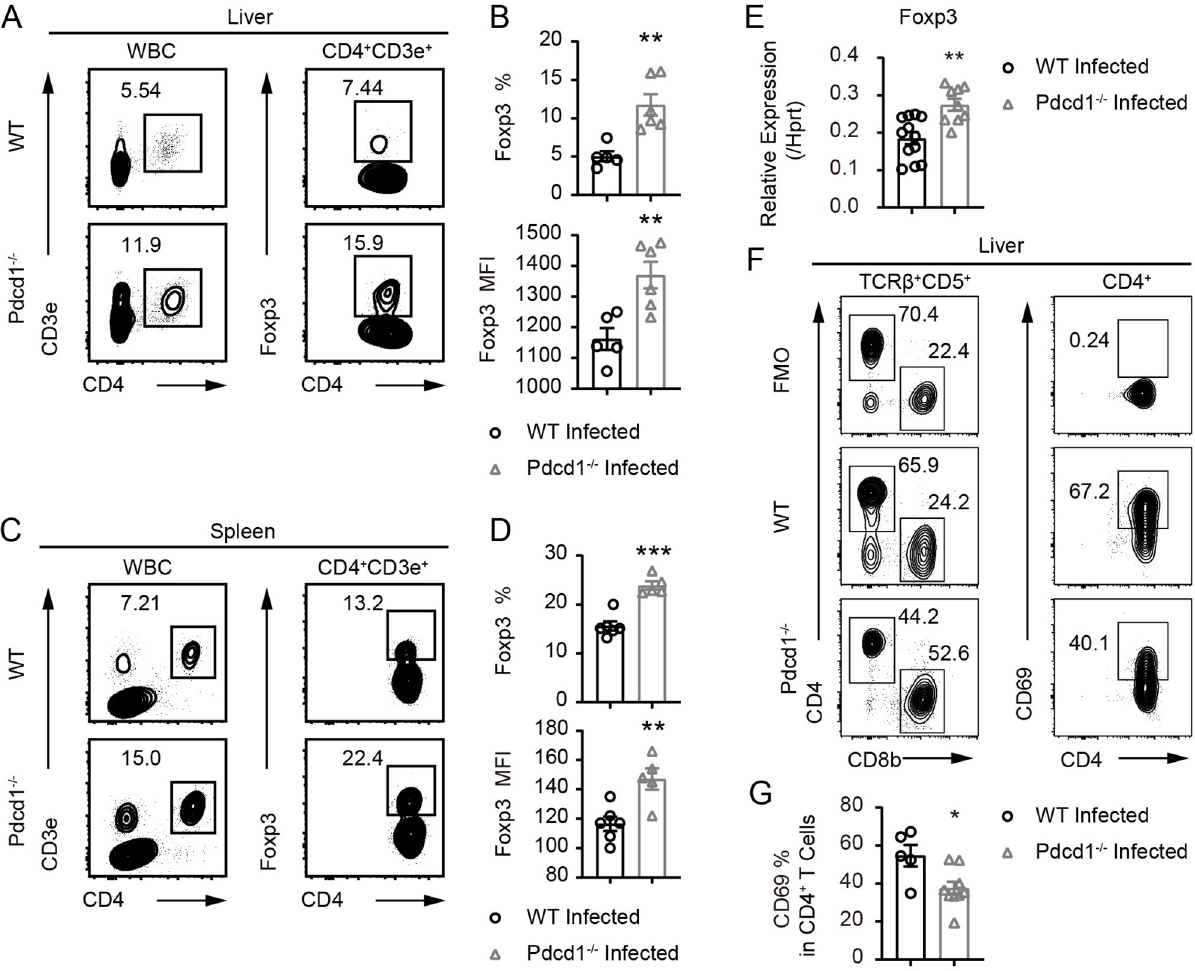
Fig 5. PD-1 deficiency robustly boosts regulatory T cells and inhibit T cell activation in S . japonicum infected mice. (A-B) Flow cytometric analyses of Foxp3 expression in CD4 + T cells in the livers of WT and PD-1-deficient Pdcd1 −/− mice infected with S . japonicum for 8 weeks (WT mice, n = 5; KO mice, n = 6). (C-D) Flow cytometric analyses of Foxp3 expression in CD4 + T cells in spleens of WT and PD-1-deficient mice infected with S. japonicum for 8 weeks (WT mice, n = 6; KO mice, n = 5). (E) qRT-PCR analyses of Foxp3 mRNAs in T cells purified from splenocytes of WT and PD-1-deficient mice infected with S . japonicum for 8 weeks (WT mice, n = 4; KO mice, n = 3; each sample analyzed in 3 replicates). (F-G) Flow cytometric analyses of CD69 expression in CD4 + T cells in the livers of WT and PD-1-deficient mice infected with S . japonicum for 8 weeks (WT mice, n = 5; KO mice, n = 9). Data represent the mean ± s.e.m. Statistical significance was assessed by unpaired Student’s t -test or non-parametric unpaired Mann-Whitney test and indicated by � P < 0.05, �� P < 0.01, ��� P < 0.001.